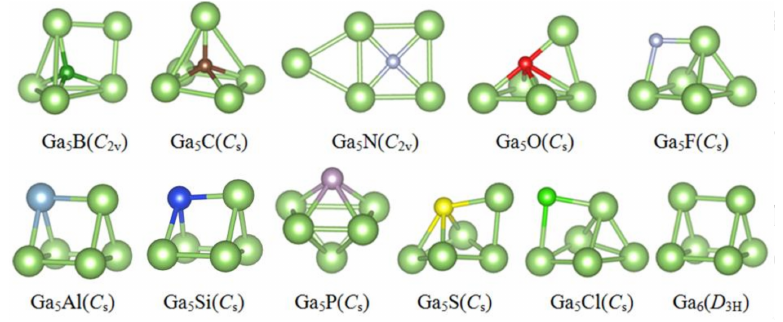
Figure 1. Optimized geometries of the lowest energy Ga 5 X (X = B, C, N, O, F, Al, Si, P, S, Cl, Ga)